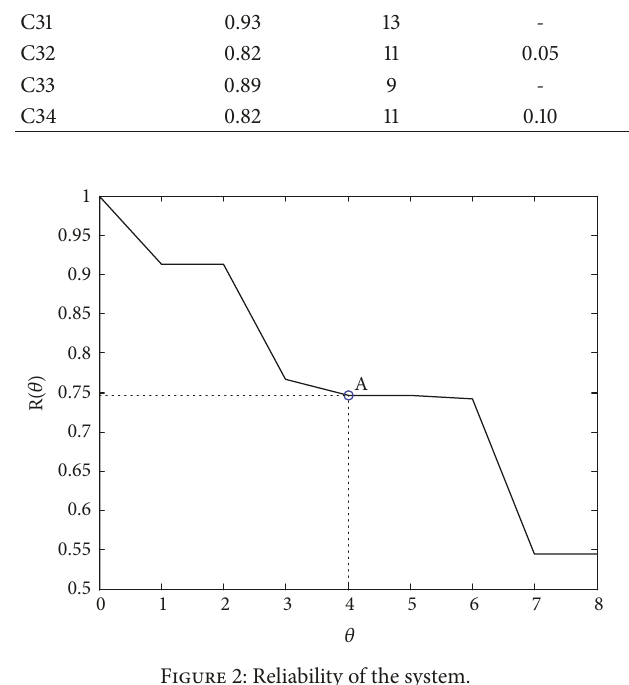
Figure 2: Reliability of the system.